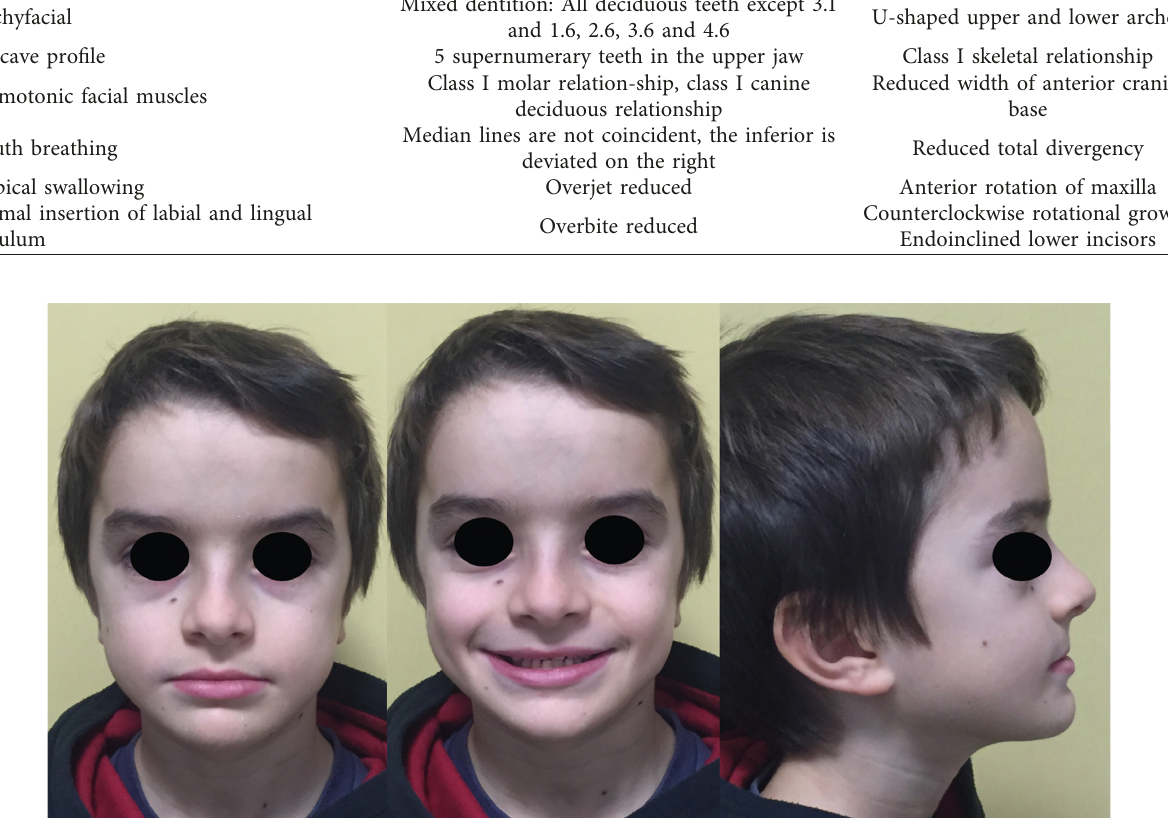
Figure 3: Case 1: pretreatment facial